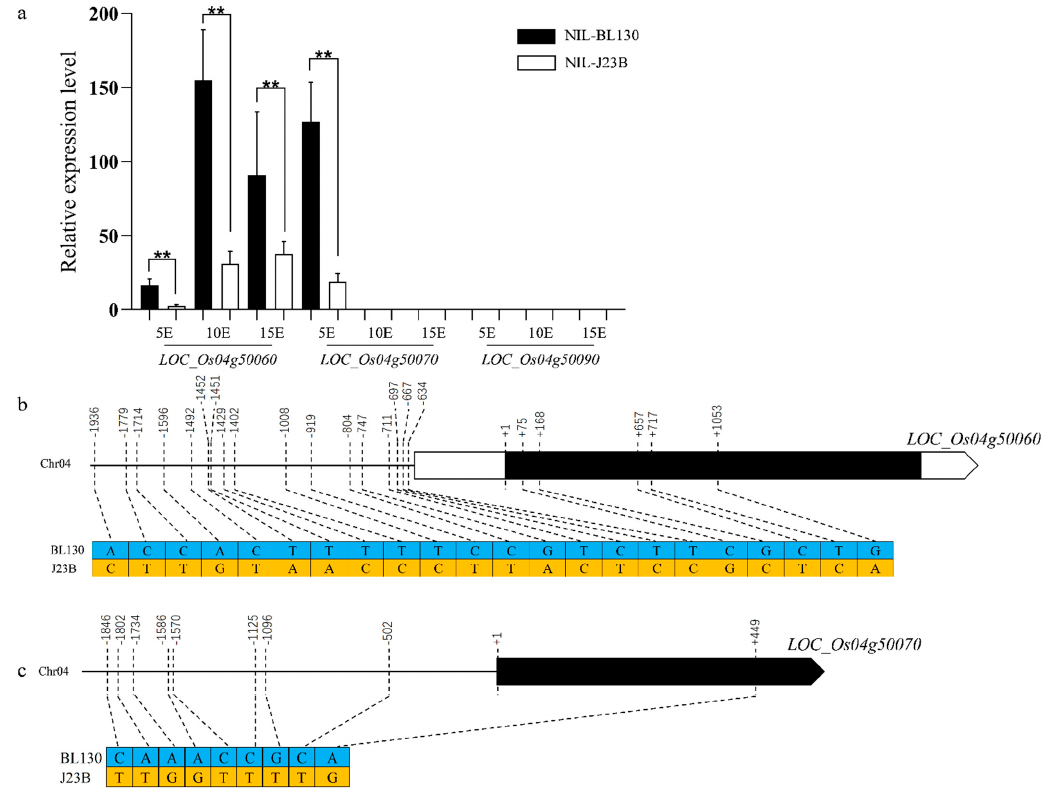
Figure 3. Expression and sequence variations of two candidate genes in qWCR4 locus. ( a ) Relative expression level analysis of three candidate genes. LOC_Os04g50060 , LOC_Os04g50070, and LOC_Os04g50090 represent three causal genes underlying the qWCR4 locus. 5E, 10E, and 15E mean endosperm 5 days, 10 days, and 15 days after pollination, respectively. ** means significant differ- ences at p < 0.01, student’s t- tests. ( b ) Variation analysis of LOC_Os04g50060 . ( c ) Variation analysis of LOC_Os04g50070 . Boxes filled with black and white in b and c mean coding and untranslated regions, respectively. The solid lines on the left side of boxes in b and c mean the promotor region. The dotted lines on the solid lines and boxes in b and c represent the position from the translation initiation site (ATG), + and − mean located in down-stream and up-stream of ATG.